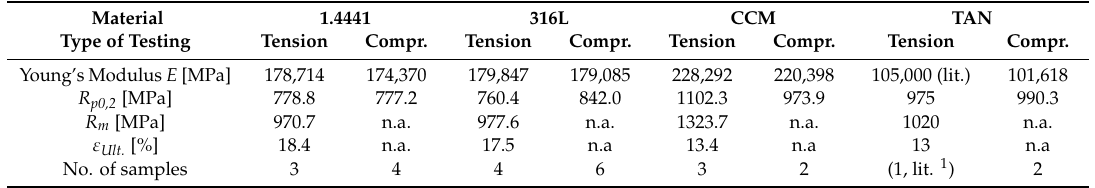
Table 1. Overview of material parameters with statistics and comparison of the test